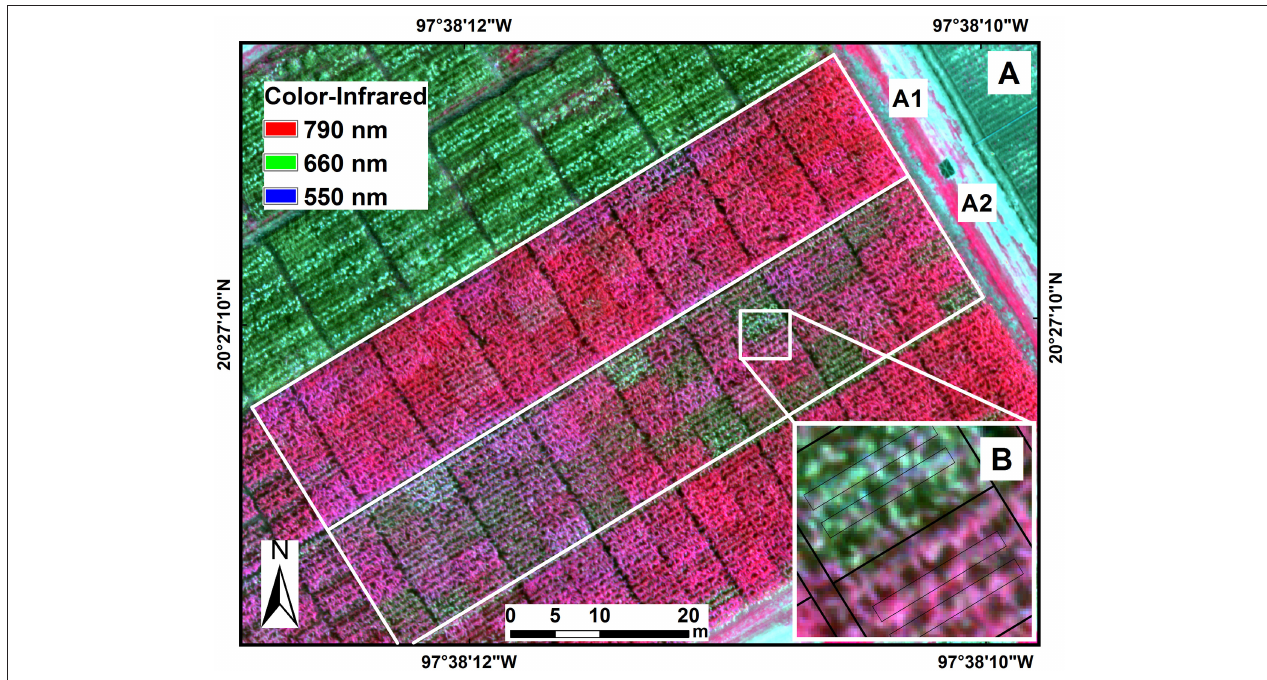
FIGURE 2 | Location of the experiment at the International Maize and Wheat Improvement Center (CIMMYT), Agua Fria experimental station in the state of Puebla, Mexico (A) . Color-infrared image (790, 660, 550nm) of maize hybrids in the experimental trials under fungicide treatment (A1) and non-fungicide treatment (A2) of tar spot complex of maize. Image data were extracted from two polygons from the two central rows in each plot (B)